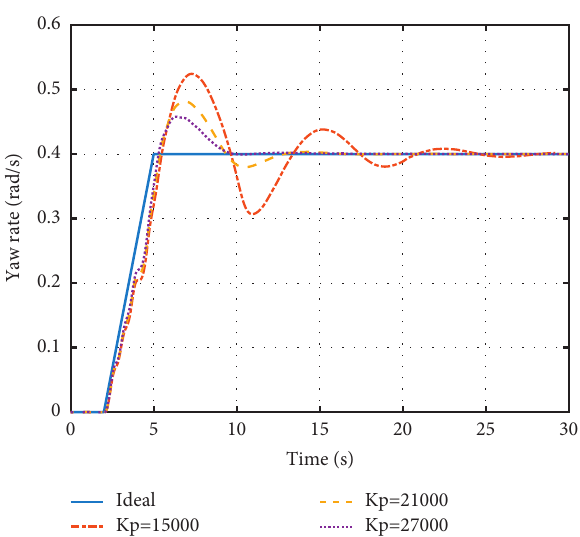
Figure 10: Yaw rate variation with different K